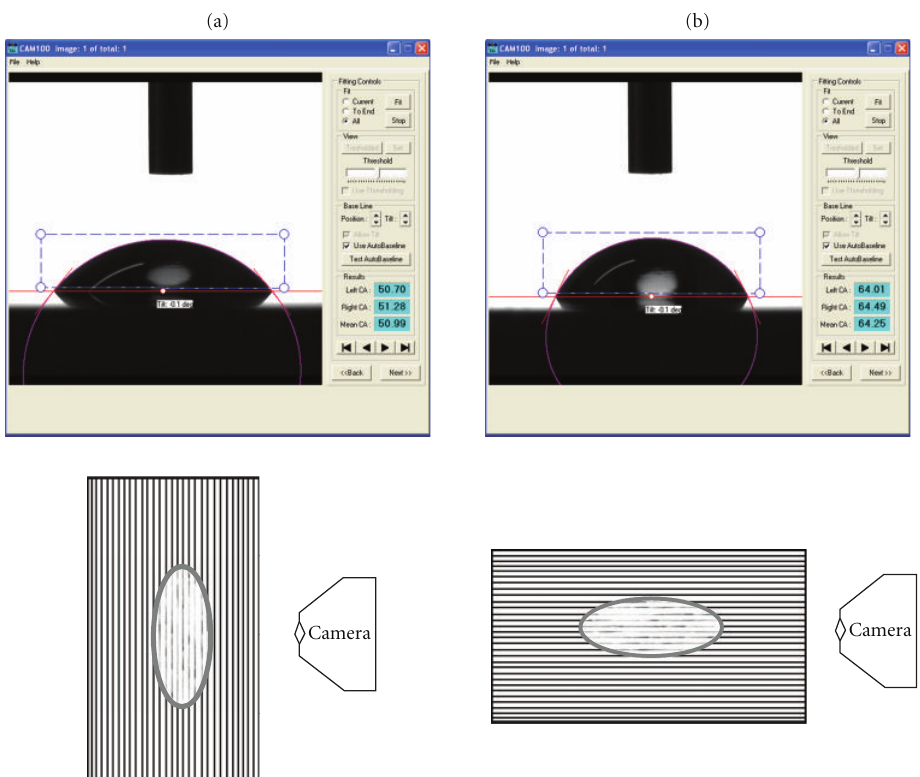
Figure 4: (a) Water contact angle measured by camera with fibers running in-plane (perpendicular) to the camera axis; (b) water contact angle measured by camera with fibers running in-plane (parallel) to the camera axis.